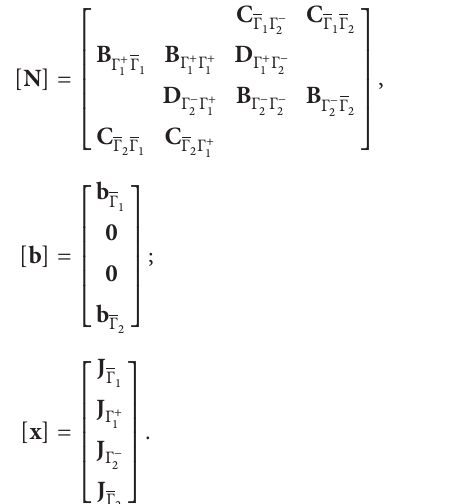
two different physics in different subregions,